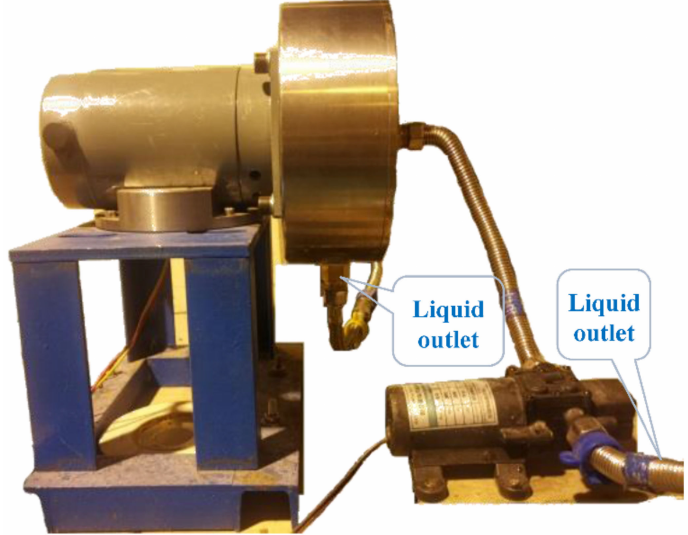
Figure 7. Physical diagram of super-gravity rapid dissolution